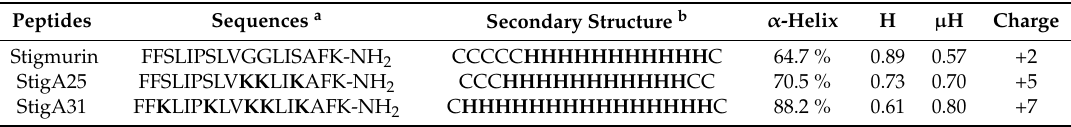
Table 1. Physiochemical properties and secondary structure predictions in silico of the peptides Stigmurin, StigA25, and StigA31.